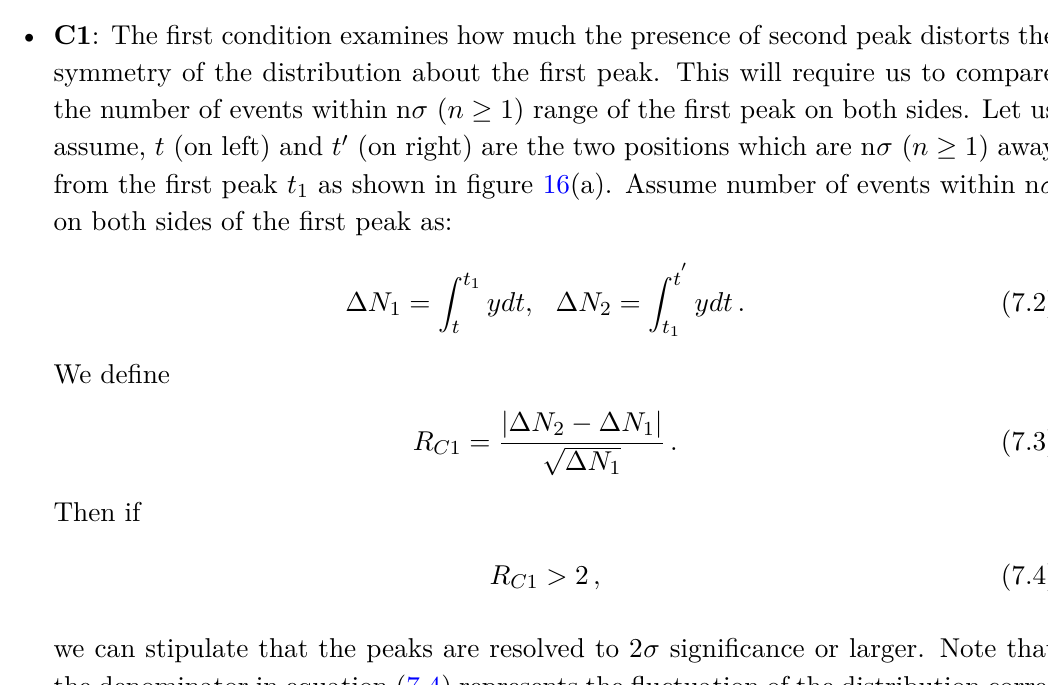
Figure 16. A schematic representation of a typical /E distribution in dσ two peaks when fitted with Gaussian function as in eq. (7.1) is shown. Left: quantities required for conditions C1 and C2 are defined (see text for details); Right: quantities required for conditions C3 and C4 are